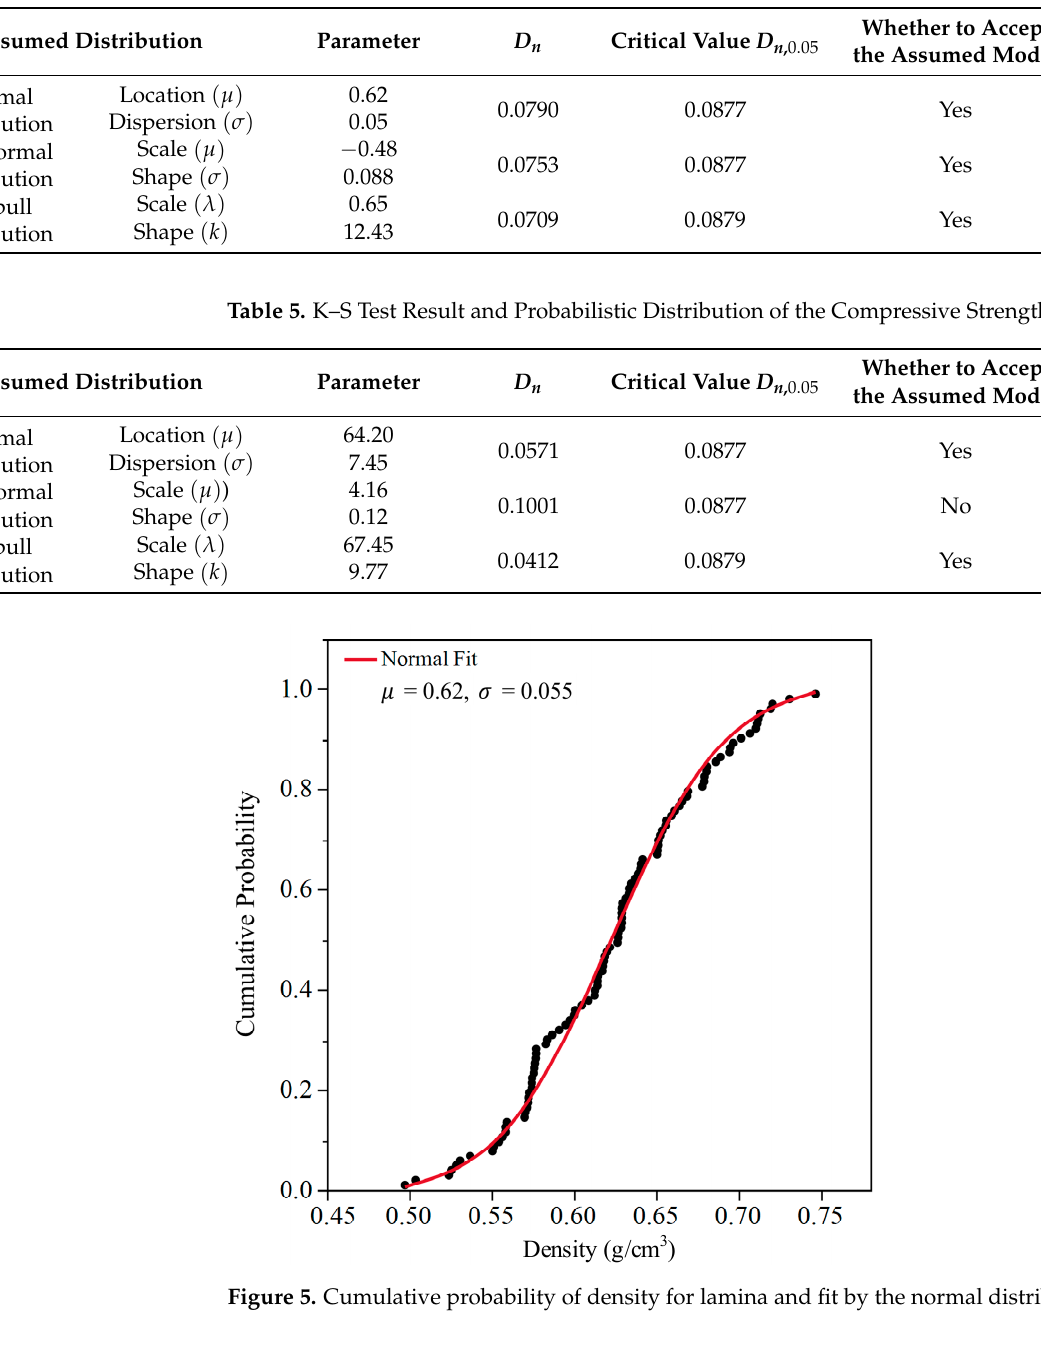
Table 4. K–S test result and probabilistic distribution of the lamina density.